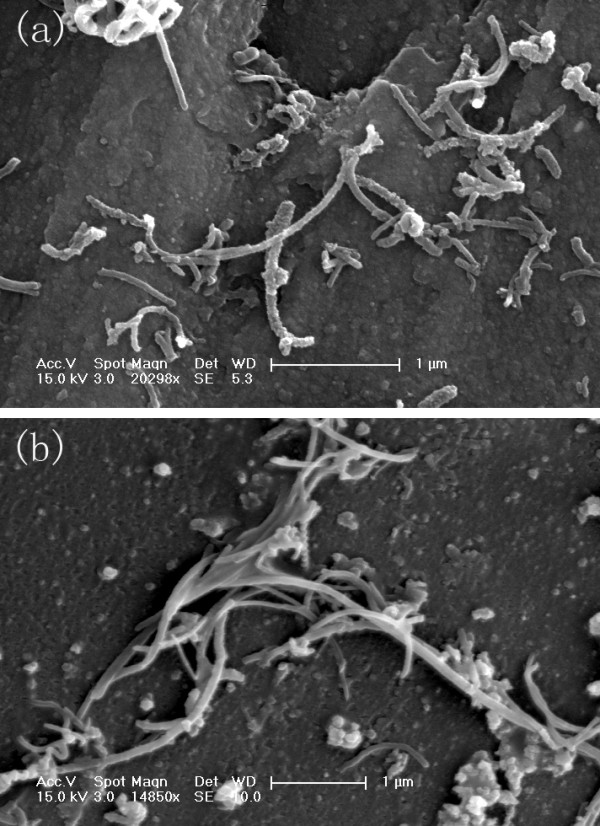
SEM images of (a) S- and (b) L-MWCNTs.